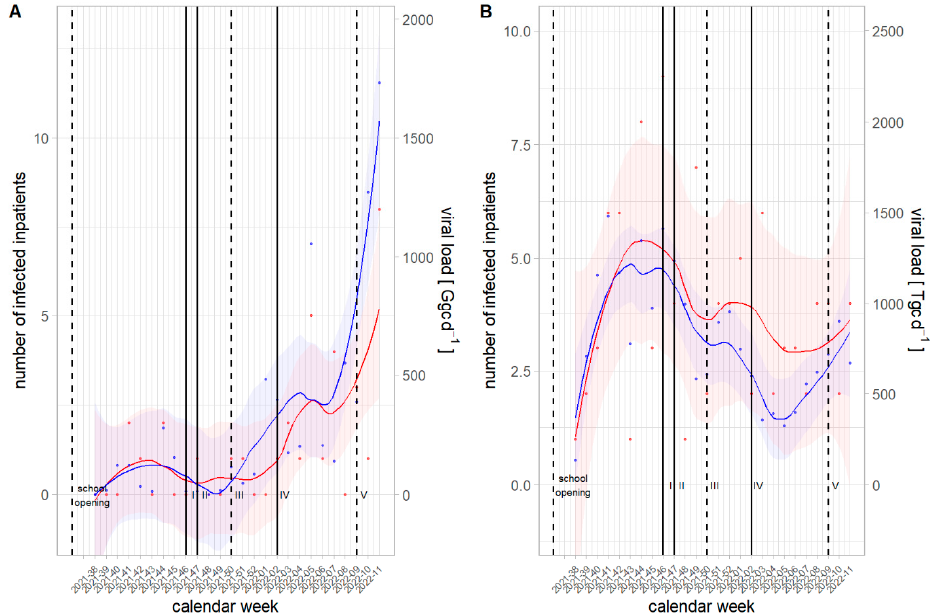
Figure 4. Comparison between viral loads in wastewater and number of infected inpatients from September 2021–March 2022 including time points for non-pharmaceutical intervention for IAV ( A ) and NoV GII ( B ). (Blue dots) Viral loads and (red dots) number of inpatients were aggregated at a weekly basis. Smoothing lines with 95% confidence bands correspond to LOWESS-smoothing. Six events increasing or decreasing the impact of NPIs on the spread of the COVID-19 pandemic were set from September 2021 to March 2022: September 9–school opens, (I) November 15—lockdown for those unvaccinated, (II) November 22nd—complete lockdown, (III) December 12—partial opening, (IV) January 11—Omicron measures, (V) March 5—complete